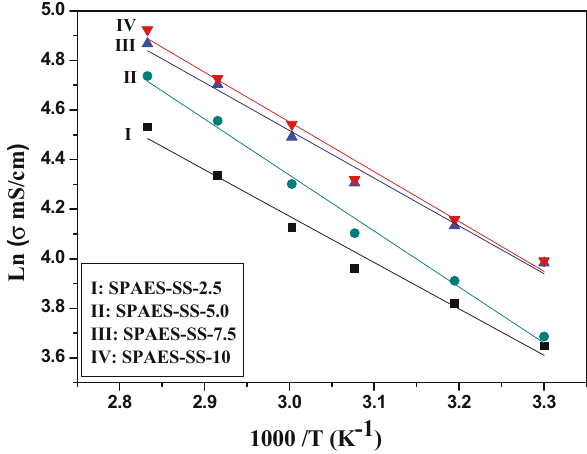
Figure 11: Temperature - dependent proton conductivity ( σ ) of the hybrid